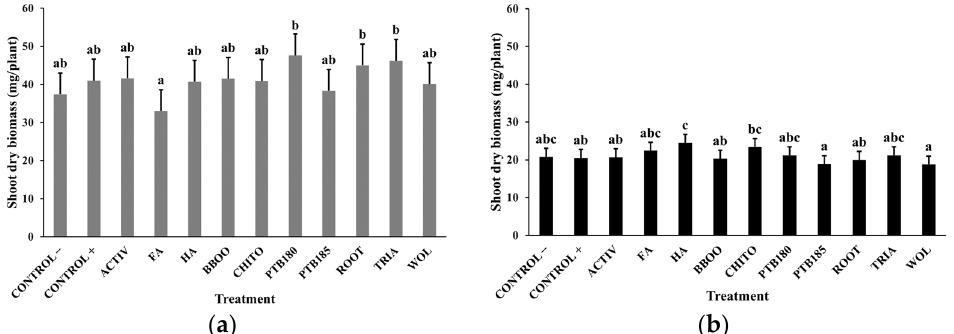
Figure 4. Effect of biostimulants on the shoot dry biomass of baby leaf lettuce plants grown in a substrate inoculated with Pythium ultimum under organic ( a ) and conventional ( b ) management. The substrate was drenched with Ascophyllum nodosum extract (ACTIV), fulvic acid (FA), humic acid (HA), bamboo vinegar (BBOO), chitosan (CHITO), Bacillus pumilus PTB180 (PTB180), Bacillus subtilis PTB185 (PTB185), Trichoderma harzianum T ‐ 22 (ROOT), triacontanol (TRIA), or wollastonite (WOL). Control seeds were sown in a substrate that was drenched with water (no biostimulants) and inoculated with P. ultimum (CONTROL +) or non ‐ inoculated with P. ultimum (CONTROL − ). Each value represents the mean of 8 replicates ± standard error. The means sharing a same letter are not significantly different according to Fisher’s protected LSD test ( p ≤ 0.05).